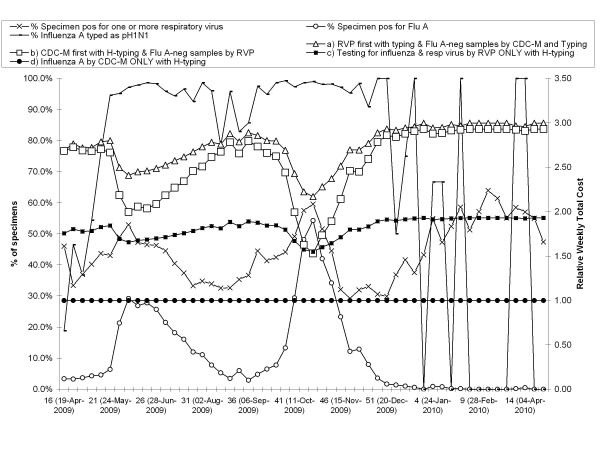
Rate of specimens positive for respiratory virus(es), influenza A and Pandemic H1N1 (2009) and the relative total weekly test cost per specimen for Scenarios A-D during April 19 2009 to April 24, 2010. The relative cost of each algorithm is calculated as the ratio of each algorithm to the lowest cost of any algorithm for the same time period.